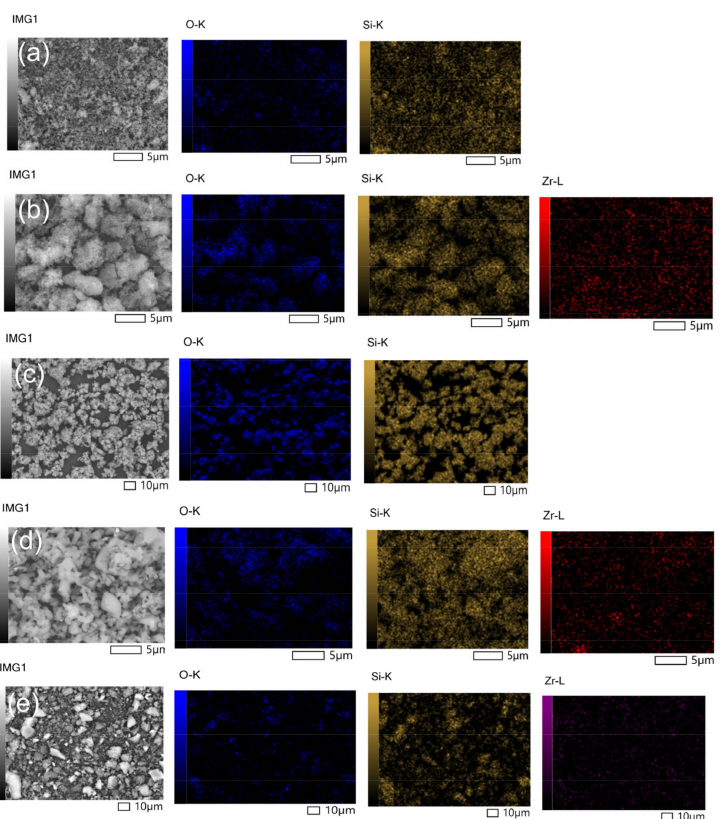
Figure 4. EDX mapping of ( a ) SiO 2 ( b ) SiO 2 /Zr ( c ) SiO 2 -TEDTA ( d ) SiO 2 /Zr-TEDTA and ( e ) SiO 2 /Zr-CEDTA. The N 2 physisorption of SiO 2 , SiO 2 /Zr, and their modification using chelate and template methods are presented in Figure 5. Based on the IUPAC categorization, it was apparent that all the catalysts had a type IV isotherm with a hysteresis loop of type H4, which suggested that the catalysts were mesoporous. Furthermore, the H4 hysteresis loop was related to the micropores with narrow slits feature [56].